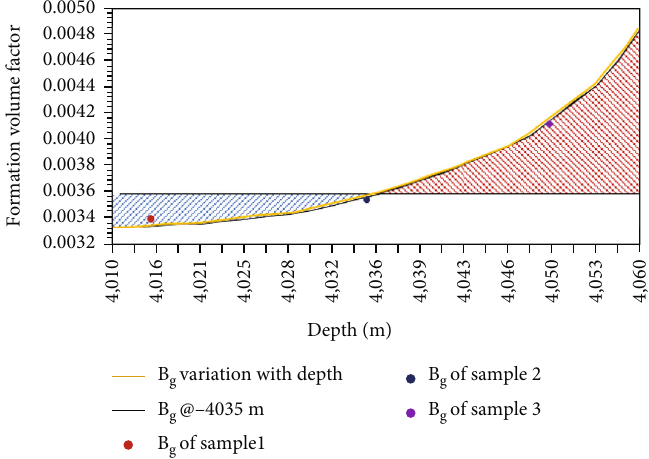
Figure 7: Formation volume factor of the original fl uid in S condensate